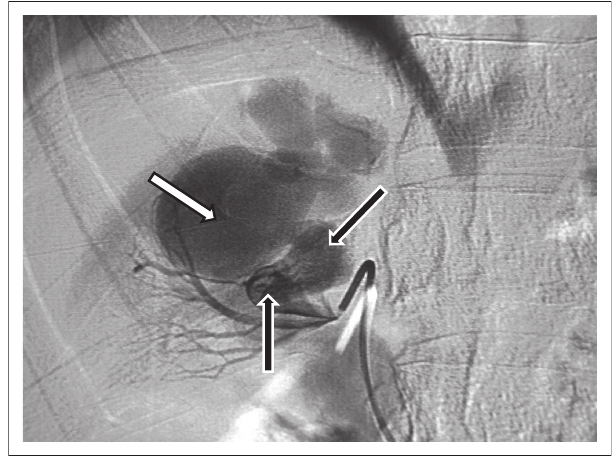
FIG URE 5: Angiogram after the second-coil embolisation demonstrating complete occlusion of the communication with coils.